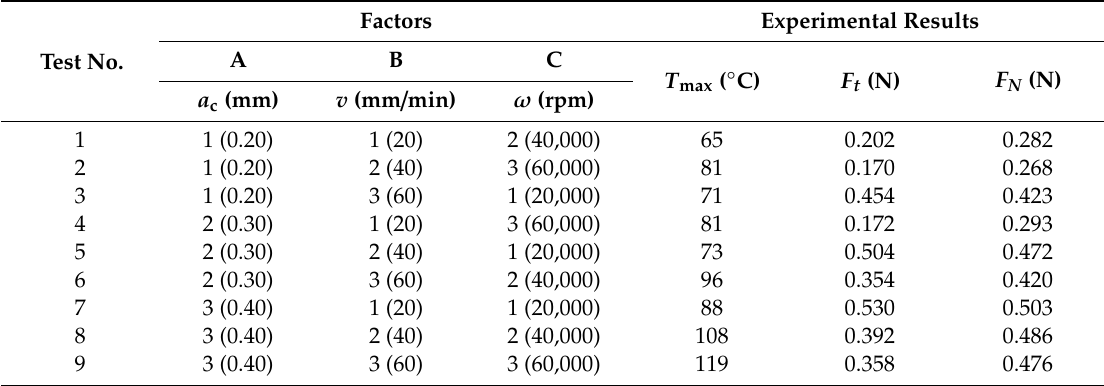
Table 2. L 9 (3 3 ) Orthogonal array and experimental